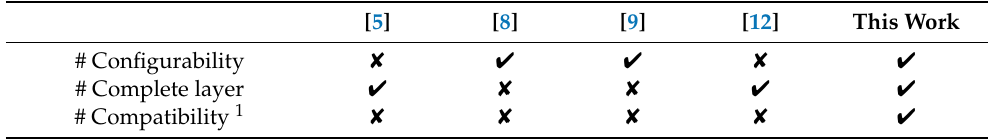
Table 2. Comparison of Functional Implementation